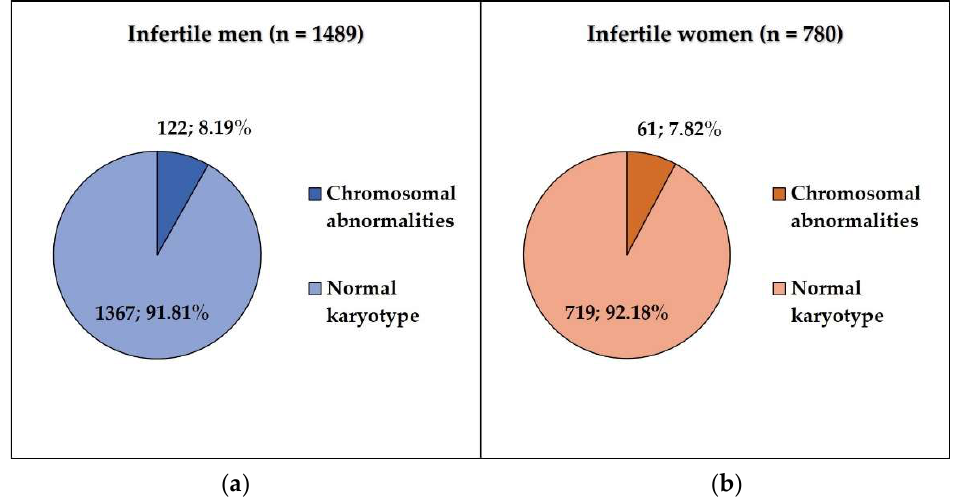
Figure 1. ( a ) The frequency of chromosomal abnormalities in infertile men; ( b ) the frequency of chromosomal abnormalities in infertile